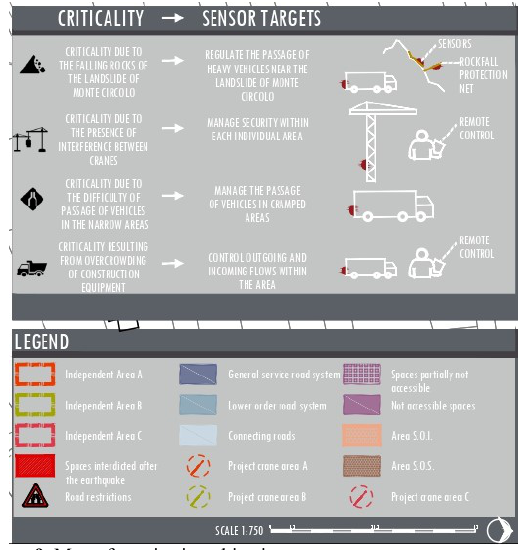
Figure 9. Map of monitoring objectives.